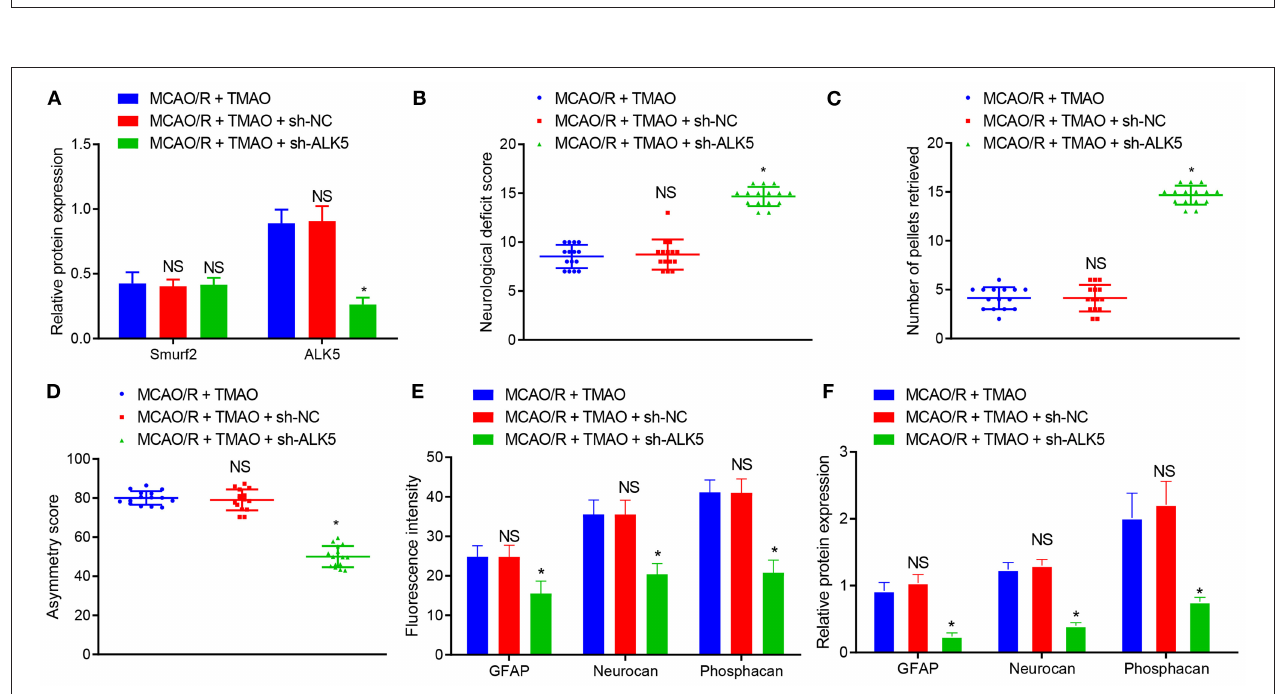
FIGURE 6 | TMAO promotes reactive astrocyte proliferation and glial scarring through the Smurf2/ALK5 axis. (A) Smurf2 and ALK5 expression determined by western blotting in brain tissues of MCAO/R rats. (B) Neurological scoring of rats after different treatments. (C) The number of collected chow pellets by rats in each group detected by staircase test. (D) Asymmetric function detected by cylinder test. (E) Expression of GFAP, Neurocan and Phosphacan detected by immunofluorescence assay in brain tissues of rats after different treatments. (F) Protein expression of GFAP, Neurocan and Phosphacan determined using Western blotting in brain tissues of rats after different treatments. * p < 0.05 compared with MCAO/R + TMAO + sh-NC group ( n = 15). NS p > 0.05 compared with MCAO/R + TMAO group ( n = 15). One-way ANOVA is employed for data comparison among multiple groups followed by Tukey’s post hoc test.